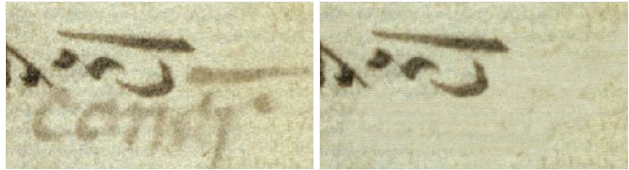
Figure 1. An example of bleed-through